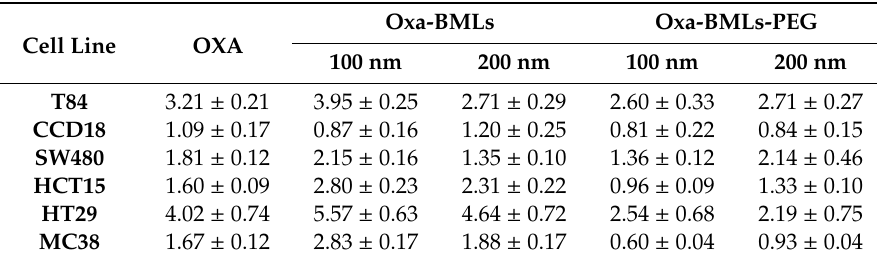
Figure 6. Cell proliferation assay of colon (tumor and non-tumor) cell lines treated with soluble Oxa, Oxa–BMLs ( A – F ) and Oxa–BMLs-PEG ( G – L ). The percentages of proliferation of T84 ( A , G ), CCD18 ( B , H ), SW480 ( C , I ), HCT15 ( D , J ), HT29 ( E , K ) and MC38 ( F , L ) cell lines obtained using are shown. Data represent the mean values ± SD of triplicate cultures. Statistically significant di ff erences with respect to free Oxa ( p < 0.05) are represented with * for NPs of 100 nm and with + for NPs of 200 nm. Table 2. Oxa-BMLs and Oxa-BMLs-PEG IC 50 ( µ M) in colon cell